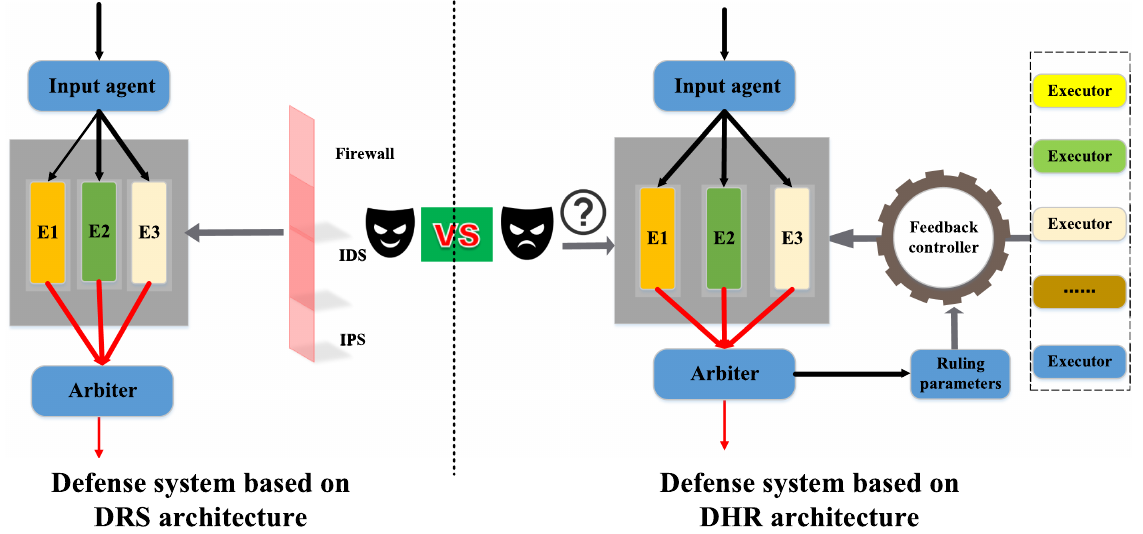
Figure 4. DRS defense system based on DRS architecture vs. Defense system based on DHR